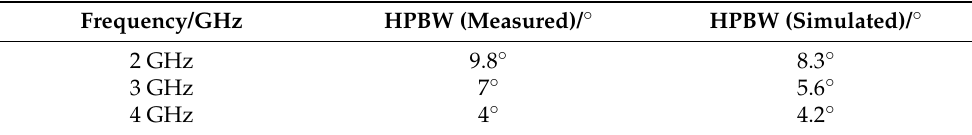
Table 6. Narrow beam Vivaldi 8-element array E-plane pattern main lobe width.